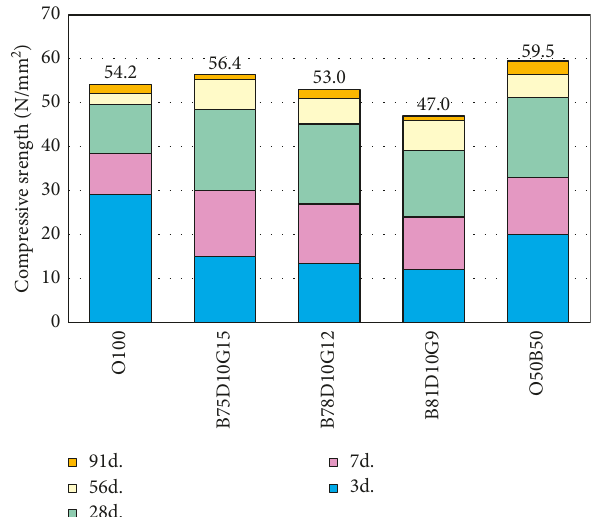
Figure 3: Compressive strength of alkali-activated mixes with BFS, DS, and